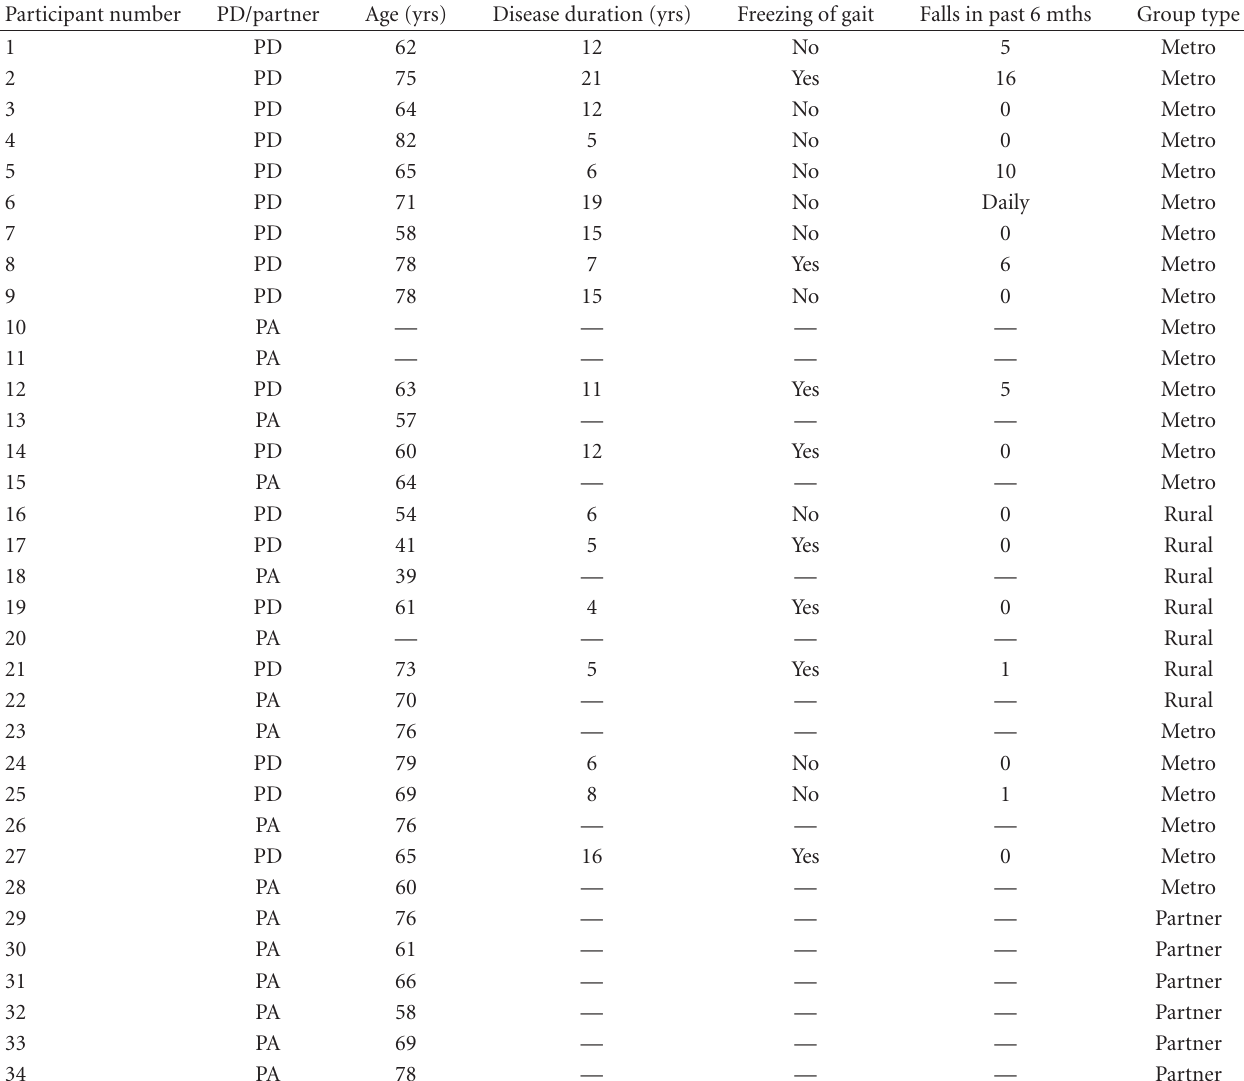
Table 1: Demographic information of study